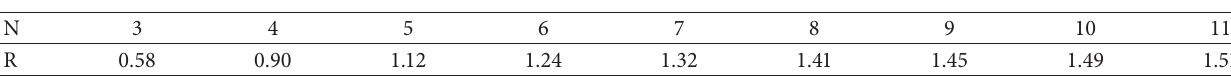
Table 2: R set value